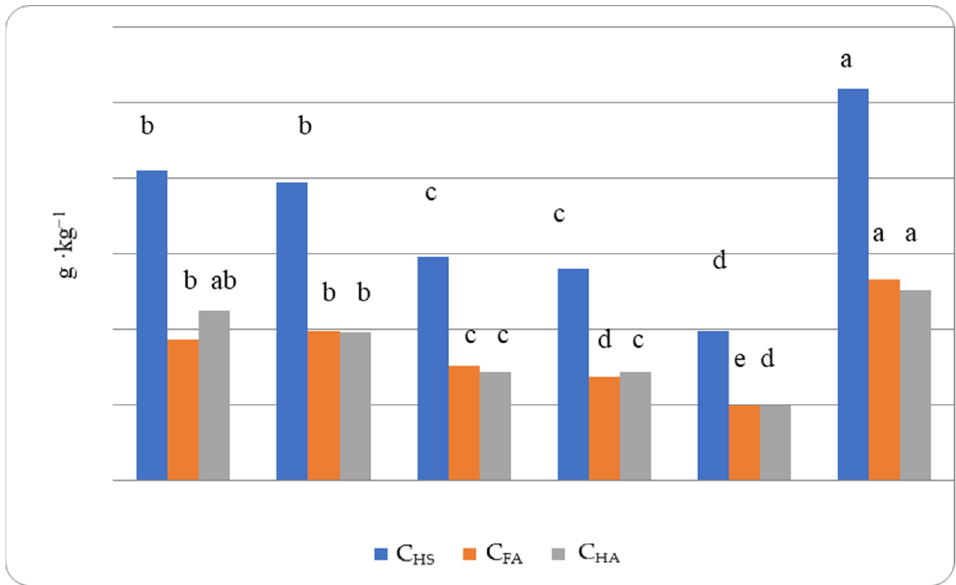
Figure 3. Contents of humic substance (C HS ), fulvic acids (C FA ) and humic acids (C HA ) in analyzed vermicomposts and composts (the same lowercase letters indicate homogeneous groups of VCs and Cs).